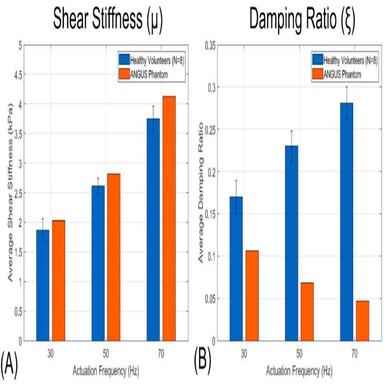
(A) Average shear stiffness (μ) values and (B) average damping ratio (ξ) values obtained from MRE at each actuation frequency in 8 healthy volunteers and the ANGUS phantom.